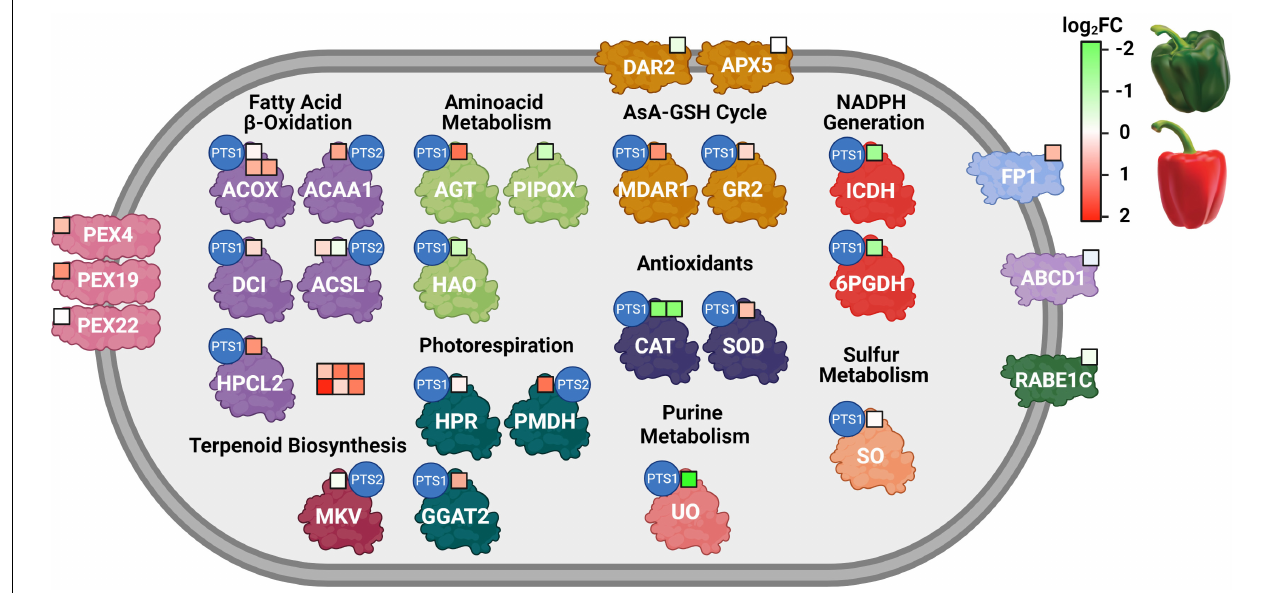
FIGURE 4 | Regulation of peroxisomal proteins during sweet pepper fruit ripening. Each colored square represents a protein. Green and red colors indicate down- and up-regulation at fruit ripening, respectively, according to log 2 FC values. 6PGDH, 6-phosphogluconate dehydrogenase; ABCD1, ABC transporter D 1; ACAA1, 3-ketoacyl-CoA thiolase; ACOX, acyl-CoA oxidase; ACSL, long-chain acyl-CoA synthetase; AGT, alanine:glyoxylate aminotransferase; APX5, L -ascorbate peroxidase 5; CAT, catalase; DCI, dienoyl-CoA isomerase; FP1, fission protein 1; GGAT2, glutamate glyoxylate aminotransferase 2; GR, glutathione reductase 2. HAO, (S)-2-hydroxy-acid oxidase; HPCL2, 2-hydroxyacyl-CoA lyase; HPR, hydroxypyruvate reductase; ICDH, isocitrate dehydrogenase; MDAR1, monodehydroascorbate reductase 1; MKV, mevalonate kinase; PEX, peroxin; PIPOX, probable sarcosine oxidase; PMDH, malate dehydrogenase 1; RABE1C, Ras-related protein